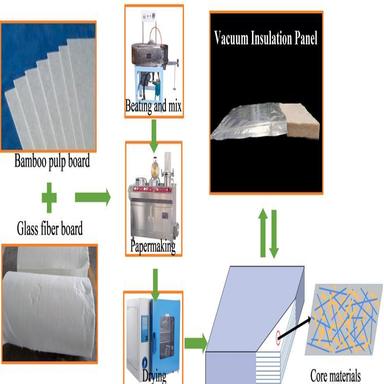
Processing of VIP preparation with hybrid core materials of bamboo and glass fiber.